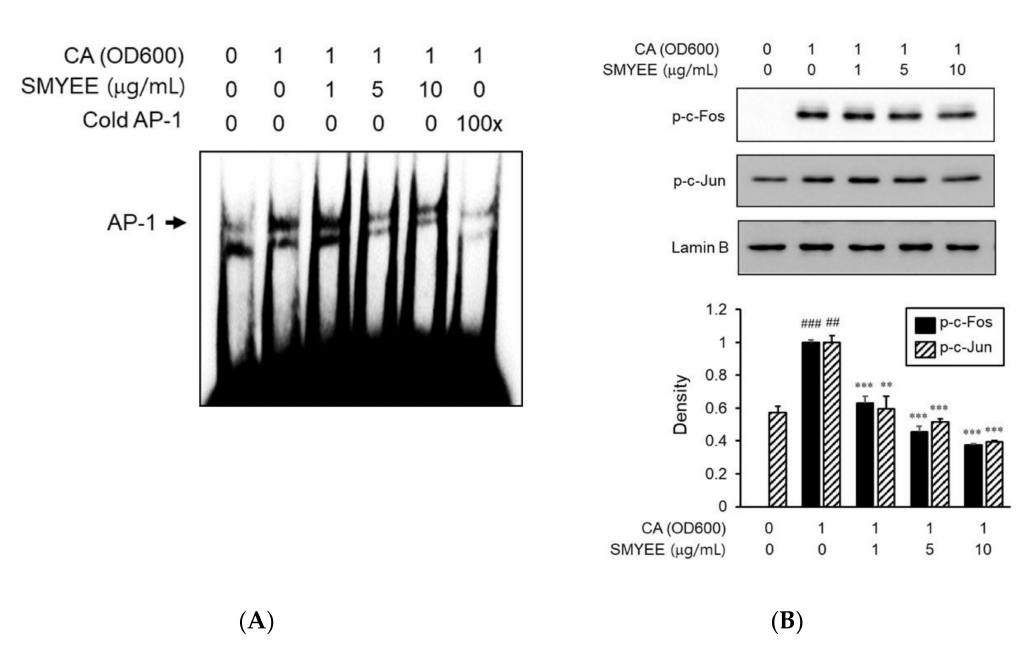
Figure 6. E ff ects of Sargassum miyabei Yendo ethanolic extract (SMYEE) on activator protein-1 (AP-1) activity in Cutibacterium acnes ( C. acnes )-induced HaCaT cells. Cells were pretreated with SMYEE (1–10 µ g / mL) for 30 min prior to stimulation with C. acnes (1 optical density at 600 nm [OD 600 ] unit) for 1 h. Nuclear extracts were analyzed in terms of AP-1 activity. ( A ) Electrophoretic mobility shift assay (EMSA) showing that SMYEE attenuated the DNA-binding activity of AP-1 in C. acnes -induced HaCaT cells. ( B ) Nuclear proteins were isolated, and c-Fos and c-Jun nuclear translocation levels were analyzed by Western blotting. The data are means ± standard error of the mean (SEM) and are representative of the results obtained in three independent experiments. ## p < 0.005 and ### p < 0.001 vs. the no-treatment group; ** p < 0.005 and *** p < 0.001 vs. the C. acnes group. CA: C. acnes